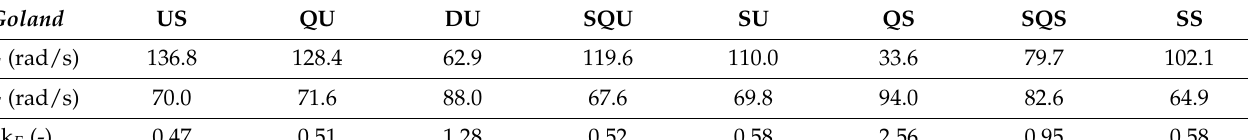
Table 8. Aero-structural properties for the typical section of Goland’s wing in incompressible flow. Goland Table 9. Flutter analysis results for Goland’s wing using different aerodynamic models. Goland